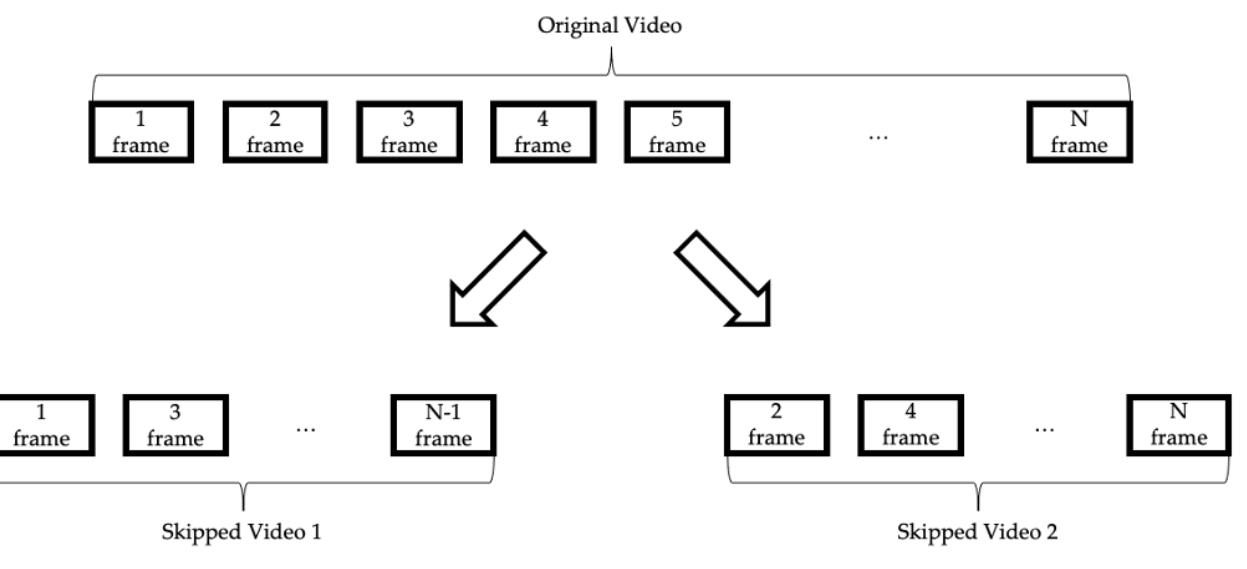
Figure 7. Frame skipping process at 2 frame intervals.